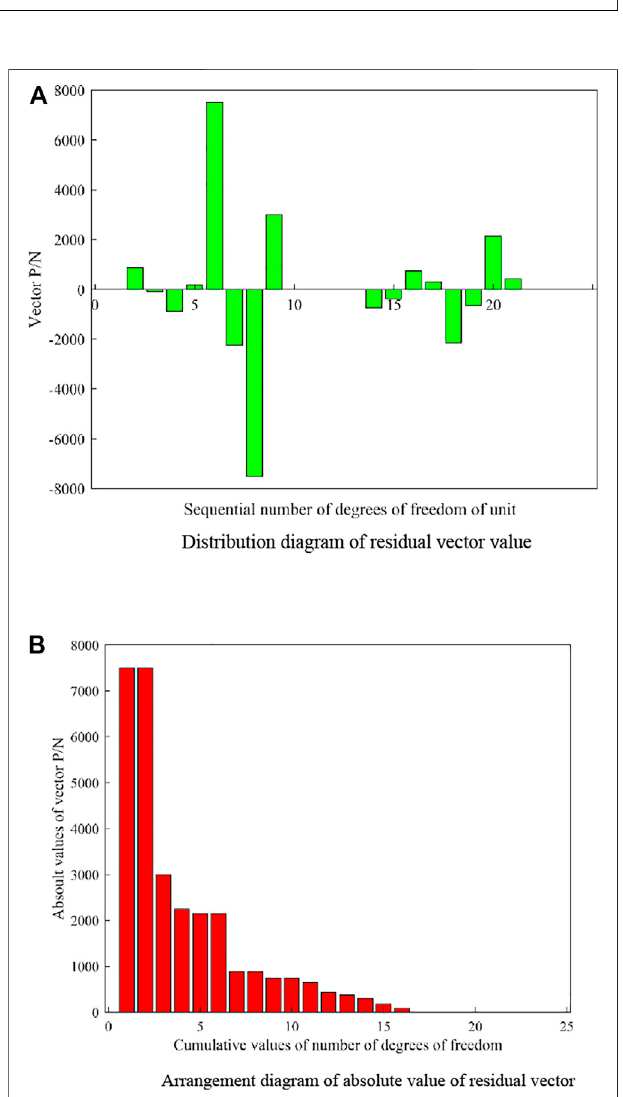
FIGURE 4 | Distribution and arrangement of residual vector values of simply supported beam. (A) Distribution diagram of residual vector value (B) Arrangement diagram of the absolute value of the residual